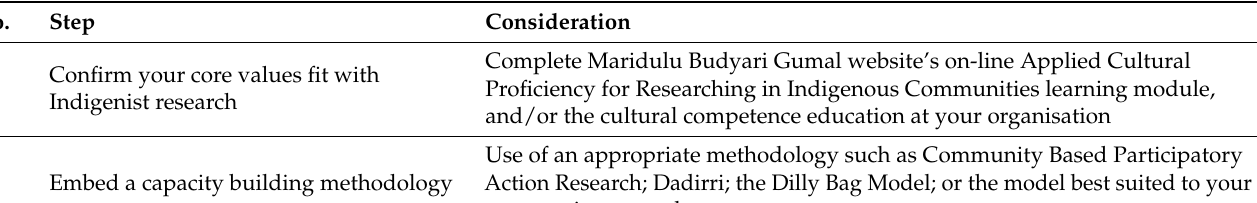
Table 1. Maridulu Budyari Gumal’s Aboriginal Health and Wellbeing Clinical Academic Group ‘Steps to success’